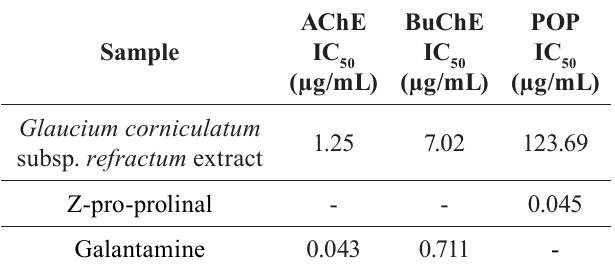
TABLE II - Enzyme inhibition activities of